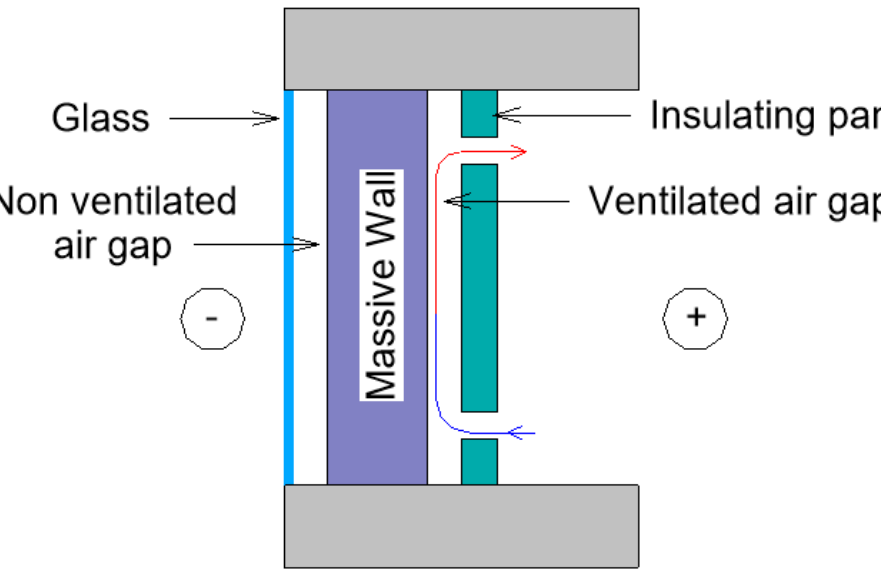
Figure 5. The Trombe–Michel wall (data from ref. [34]) .